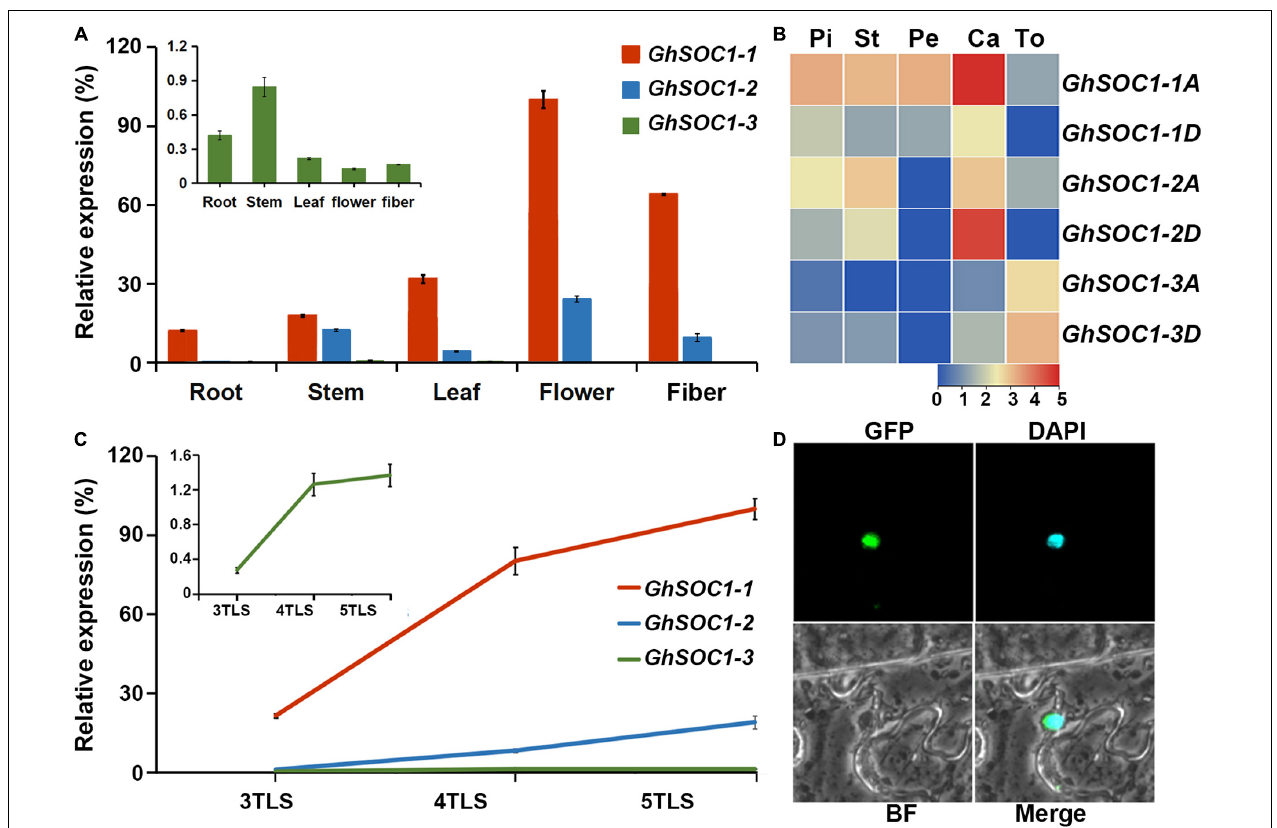
FIGURE 4 | Expression analysis of GhSOC1s . (A) Tissue specific expression of GhSOC1s in G. hirsutum . (B) Expression pattern of GhSOC1s in a flower. Pi, pistil; St, stamen; Pe, petal; Ca; calyx; To, torus. (C) Expression changes of GhSOC1s during seedling development. 3TLS, 4TLS, and 5TLS demonstrates the third, fourth and fifth true leaf stages, respectively. The expression is normalized to GhHIS and the maximum expression is set as 100%. Error bars represent the standard deviations of three biological replicates. (D) Subcellular localization of GhSOC1-1 in tobacco leaves. GFP, GFP fluorescence; DAPI, fluorescence of 40,6-diamino-2-phenylindole; BF, Bright field; Merge, merge of GFP, DAPI, and BF